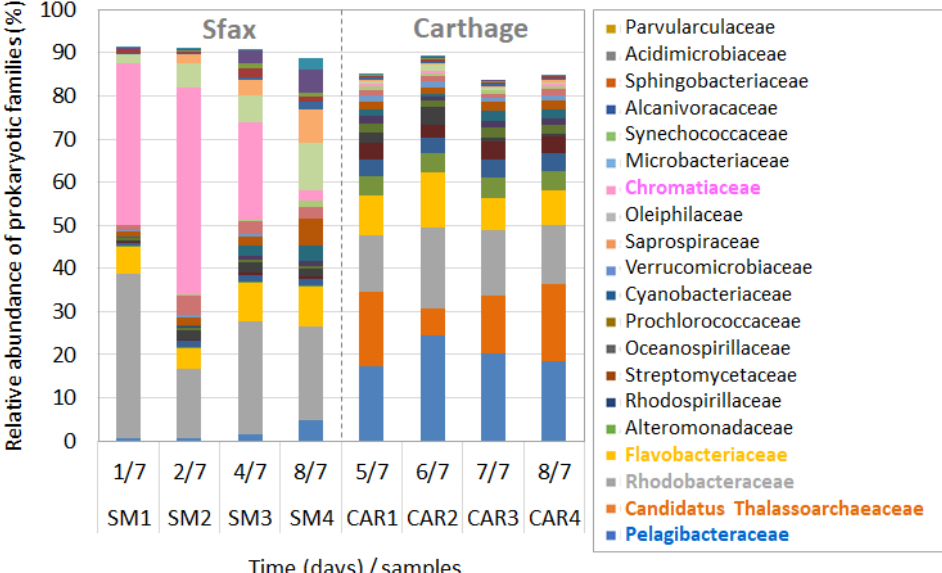
Figure 5. Compositions of prokaryotic communities at the family level in the waters of the Sfax site (Sidi Mansour (SM)) and the Carthage site (CAR) during dinoflagellate blooms. (Sidi Mansour (SM)) and the Carthage site (CAR) during dinoflagellate blooms. Pronounced variation in the prokaryotic community structure was also observed at Sfax over the sampling period (Figure 5). At the beginning of the monitoring, Rhodobacteraceae were the dominant bacteria (SM1), but they decreased with the increase in Chromatiaceae at SM2 (47%), the second monitored day, before decreasing progressively to represent only 2–3% of the community at the end of the survey (Figure 5). On the contrary, the prokaryotic diversity at these taxonomic levels was more stable during the decline of the G. impudicum bloom at Carthage, but a decrease in Ca.